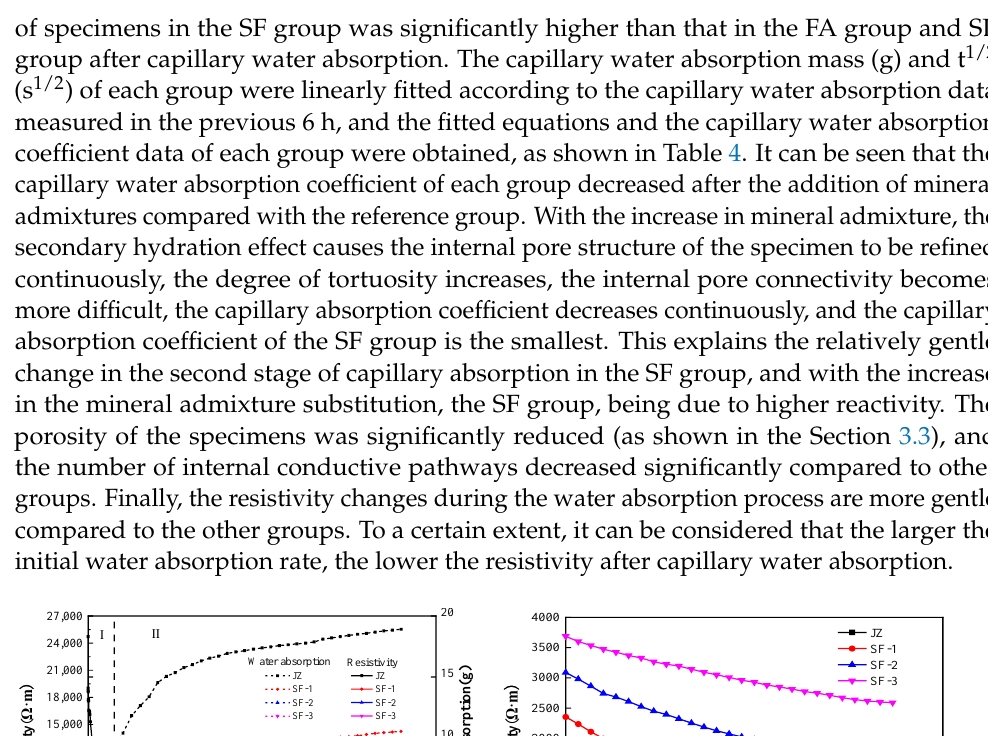
Figure 7. Changes in water absorption and resistivity of cement mortar with different SF contents over time: ( a ) Macroscopic damage; ( b ) Partially enlarged drawing.